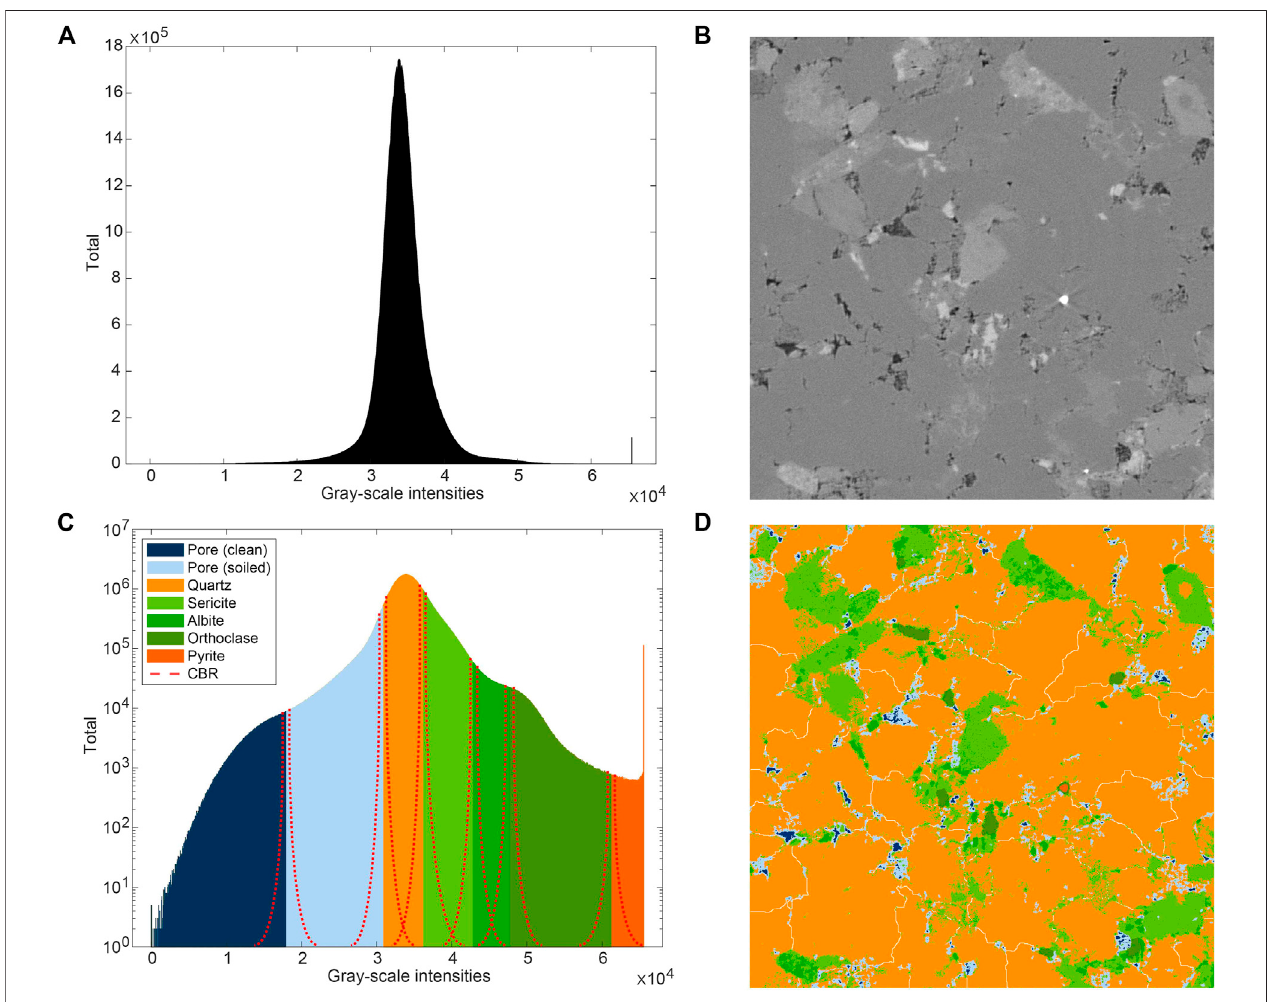
FIGURE2|(A) Gray-scaleintensities afterasubsequent 2 × 2 × 2binningoperationresultingfrom theXRCT volume and acorresponding slicein (B) withan edge lengthof800pixel. (C) Segmentedgray-scaleintensitiescolor-codedwithcorrespondingsegmentedphases.Notethatthecolor-codedboundariesre fl ecttheselected gray-scale intensity, but should not be interpreted as strict boundaries between two phases. Rather, the phase boundaries show overlapping characteristics that were adjusted by morphological post-processing operations (Sheppard et al., 2004; Jones et al., 2007). These critical areas between two phases are indicated by the critical boundary regions (CBR). (D) Segmented result with corresponding gray-scale intensities (C) of slice (B) . Additionally, high angle quartz grain boundaries are implemented by the watershed-algorithm in a white color. The fi gures were created with Avizo (2019) and Matlab